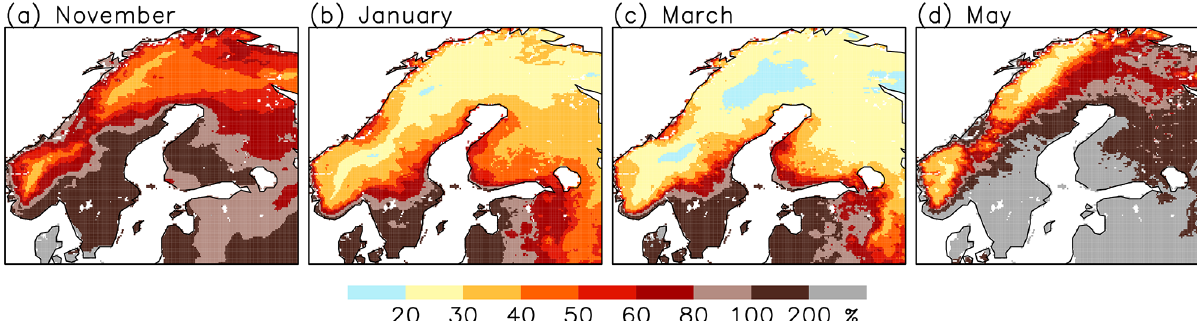
Figure A1. Coefficient of variation of the monthly mean SWE in ERA5-Land in (a) November, (b) January, (c) March and (d)